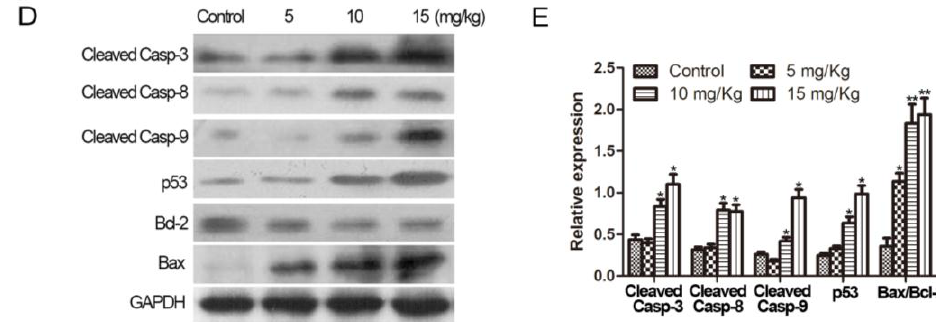
Figure 7. Methyl Sartortuoate at the indicated concentrations inhibited the growth of LoVo cells in nude mice. ( A ) LoVo cells were subcutaneously inoculated into the right flank of nude mice. The mice were randomly divided into four groups ( n = 7) and treated intraperitoneally with Methyl Sartortuoate (5, 10, 15 mg/kg) or DMSO (dissolved in sodium chloride, control) every three days for 18 days. The resulting tumors were excised from the animals after treatment; ( B ) Tumor volume was measured during the experiment in the indicated days; ( C ) Tumor weight was measured after mice being sacrificed. The data experiments were presented as mean ± SD. * p < 0.05 compared with DMSO-treated group; ( D , E ) The apoptotic proteins expression in tumor tissue of mice were measured by Western blots. The relative expression of band for apoptosis-related proteins indicated by Western blots, and the bar is the standard deviation ( n = 3). * p < 0.05 and ** p < 0.01 versus control